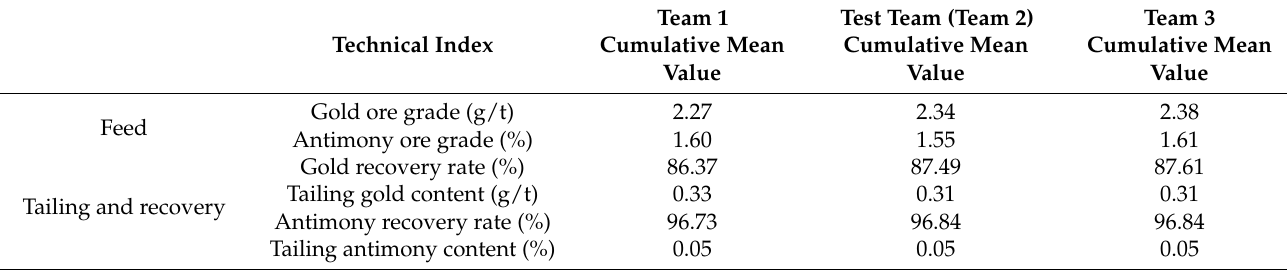
Table 13. Technical indices of each